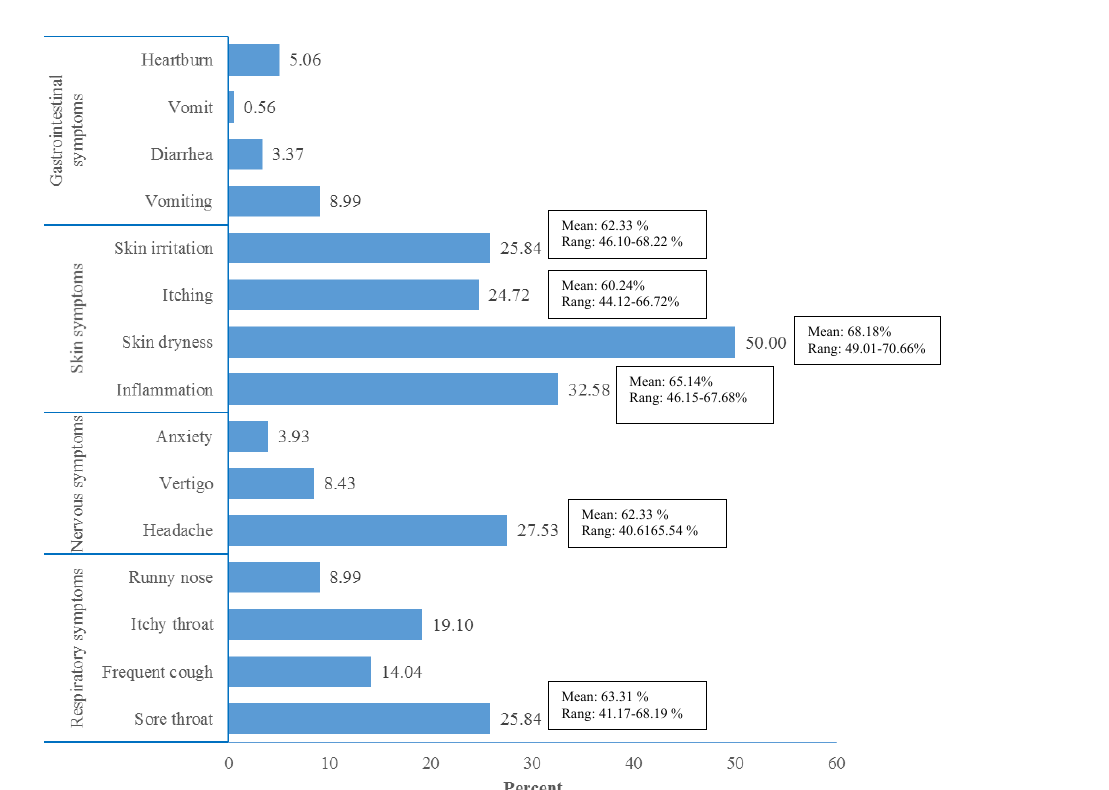
Fig 2. The percentage of side effects occurred of each symptom t he relation with percentage Figure 2. The percentage of side effects occurred of each symptom the relation with percentage mean of ethanol among hospital mean of ethanol among hospital staffs.